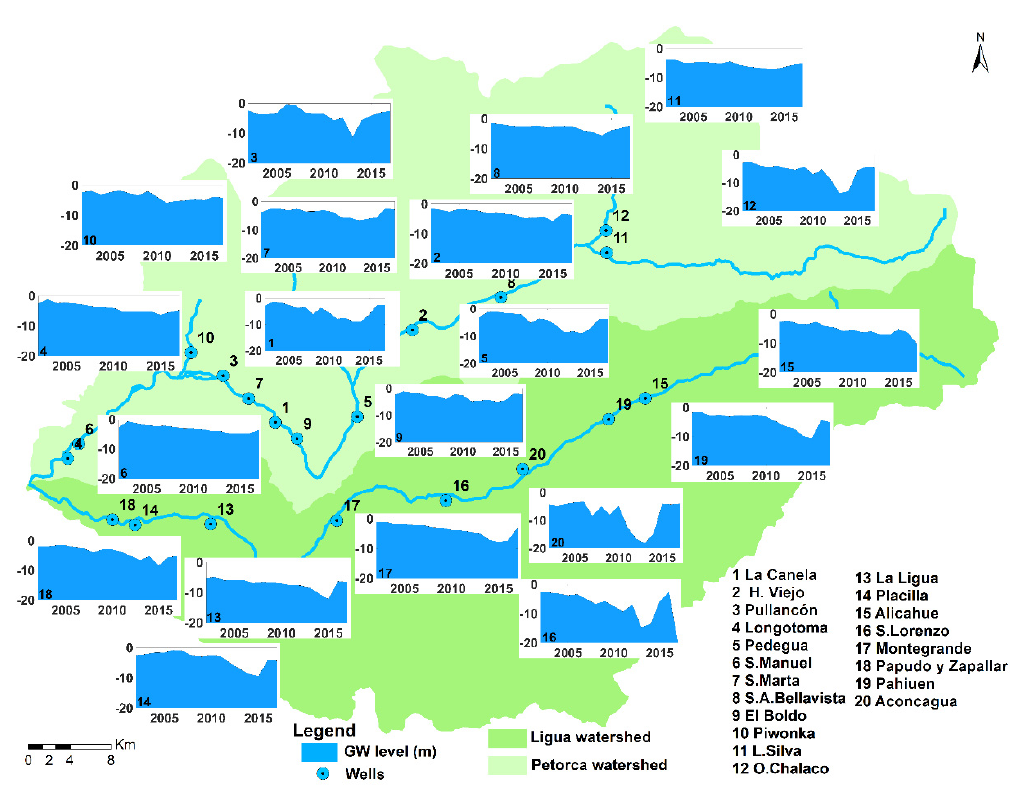
Figure 5. Spatial distribution of annual GW averages from 2002–2017 in the study area.